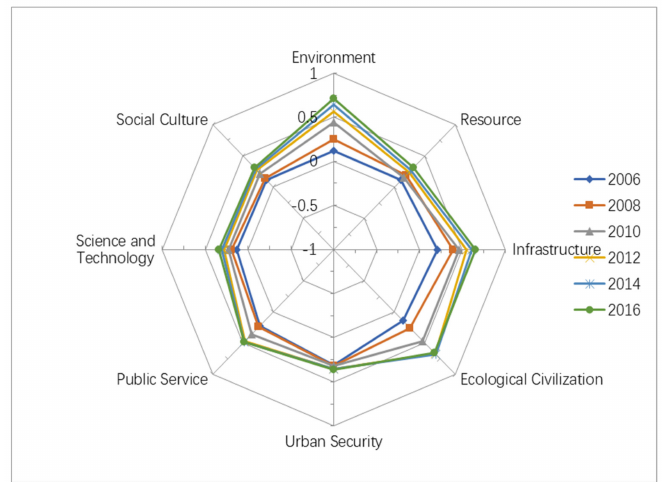
Figure 4. Results for the carrying capacity of subsystems of Harbin